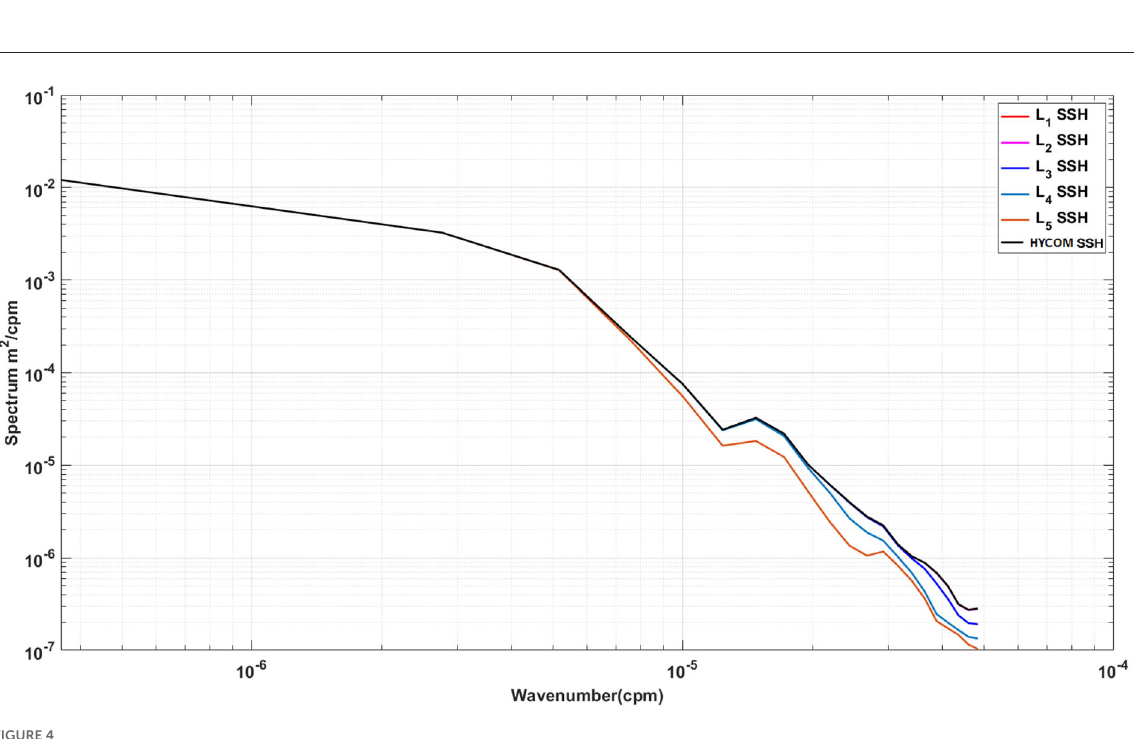
FIGURE4 Five levels of DWT Approximations SSH